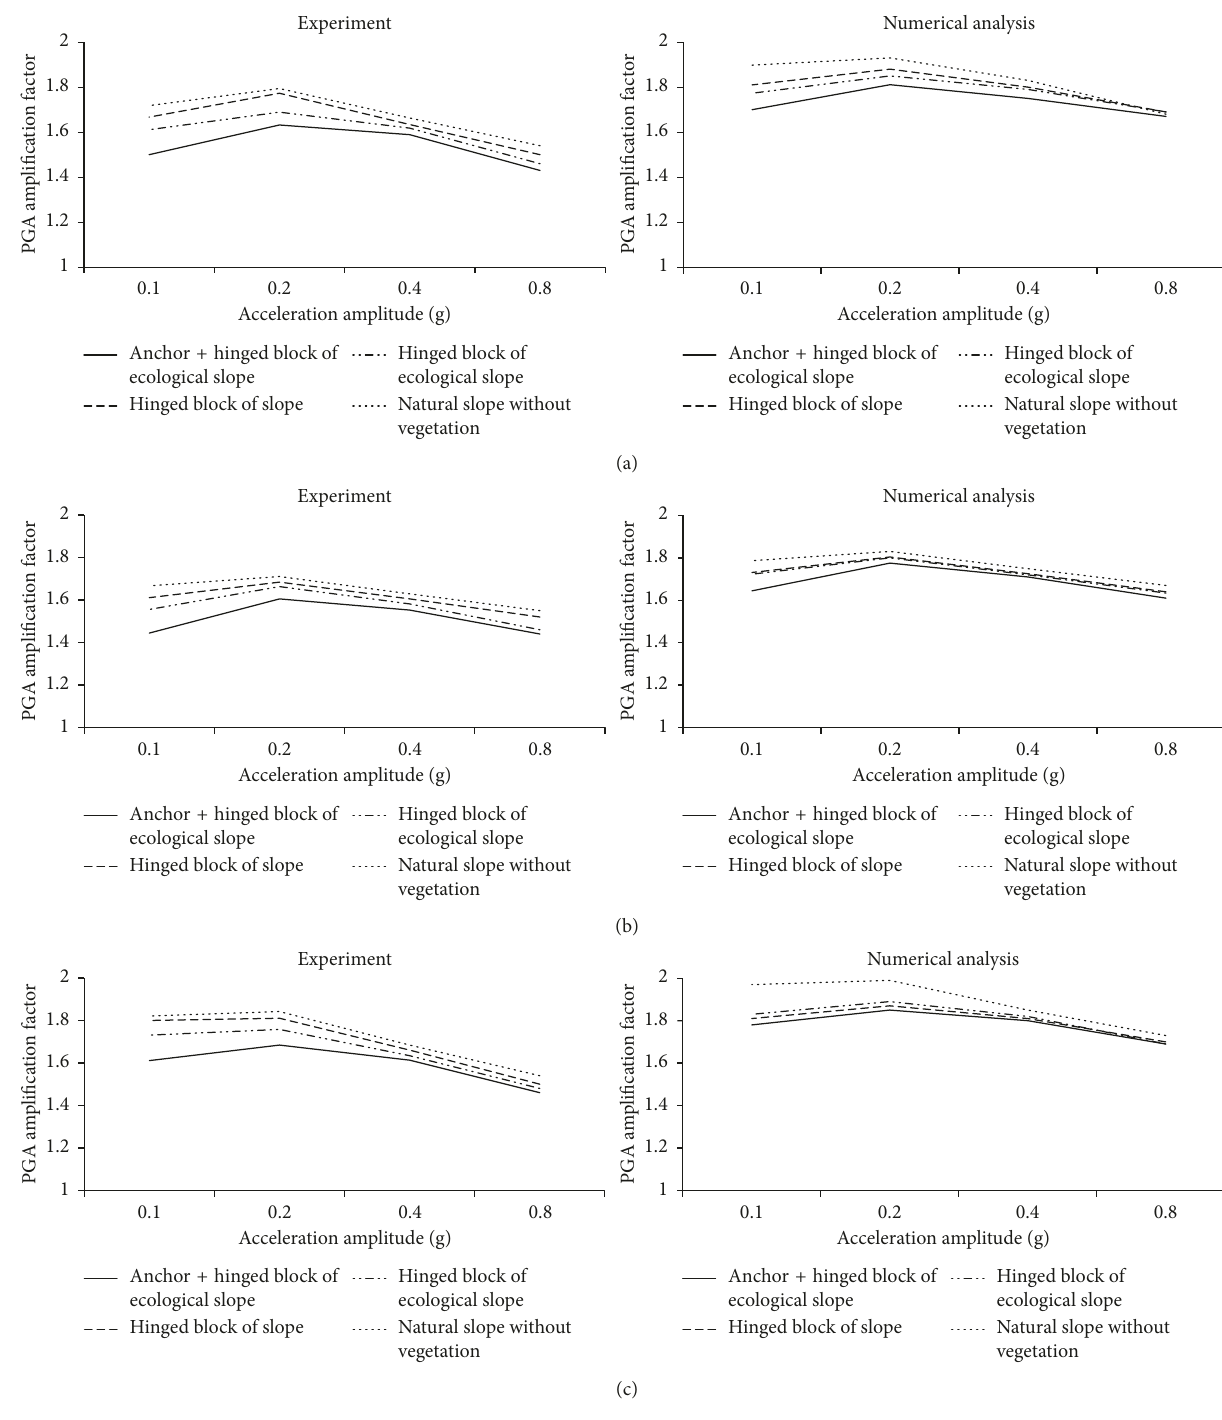
Figure 5: PGA amplification factor-acceleration amplitude curves at the same sensor point. (a) PGA amplification factor-acceleration amplitude curves at sensor point A3. (b) PGA amplification factor-acceleration amplitude curves at sensor at point A4. (c) PGA am- plification factor-acceleration amplitude curves at sensor at point